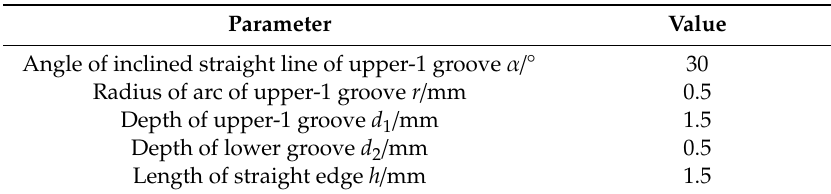
Table 1. Die parameters.